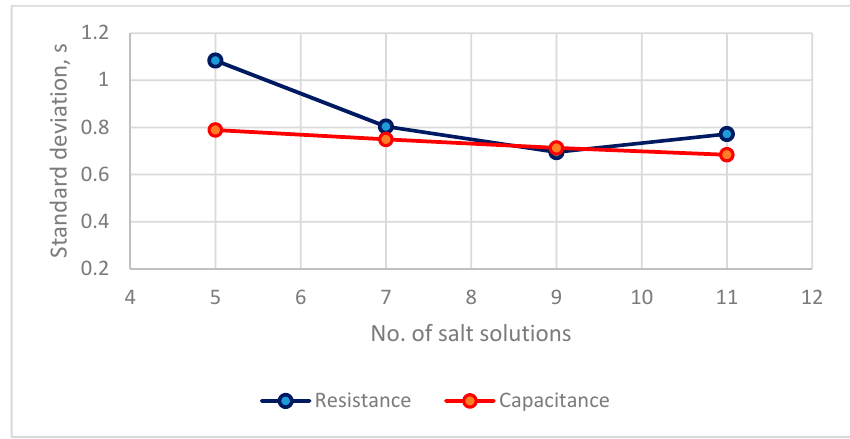
Figure 6. The distribution between numbers of saturated salt solutions and estimated standard errors of calibration equations of two types of RH sensors.